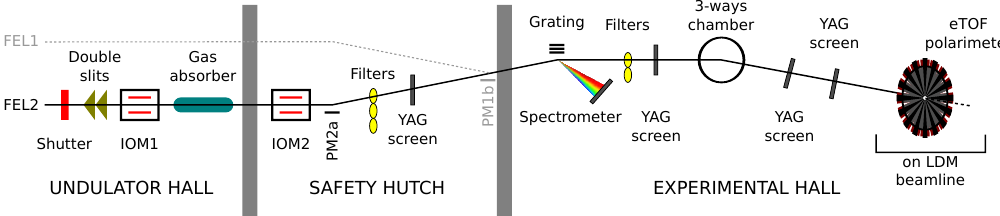
Figure 2. Schematic layout of the PADReS system to transport the light from FEL-2 to the LDM endstation where the eTOF polarimeter is installed. (IOM: ionization monitor, PM: plane mirror, YAG: Yttrium aluminium garnet).